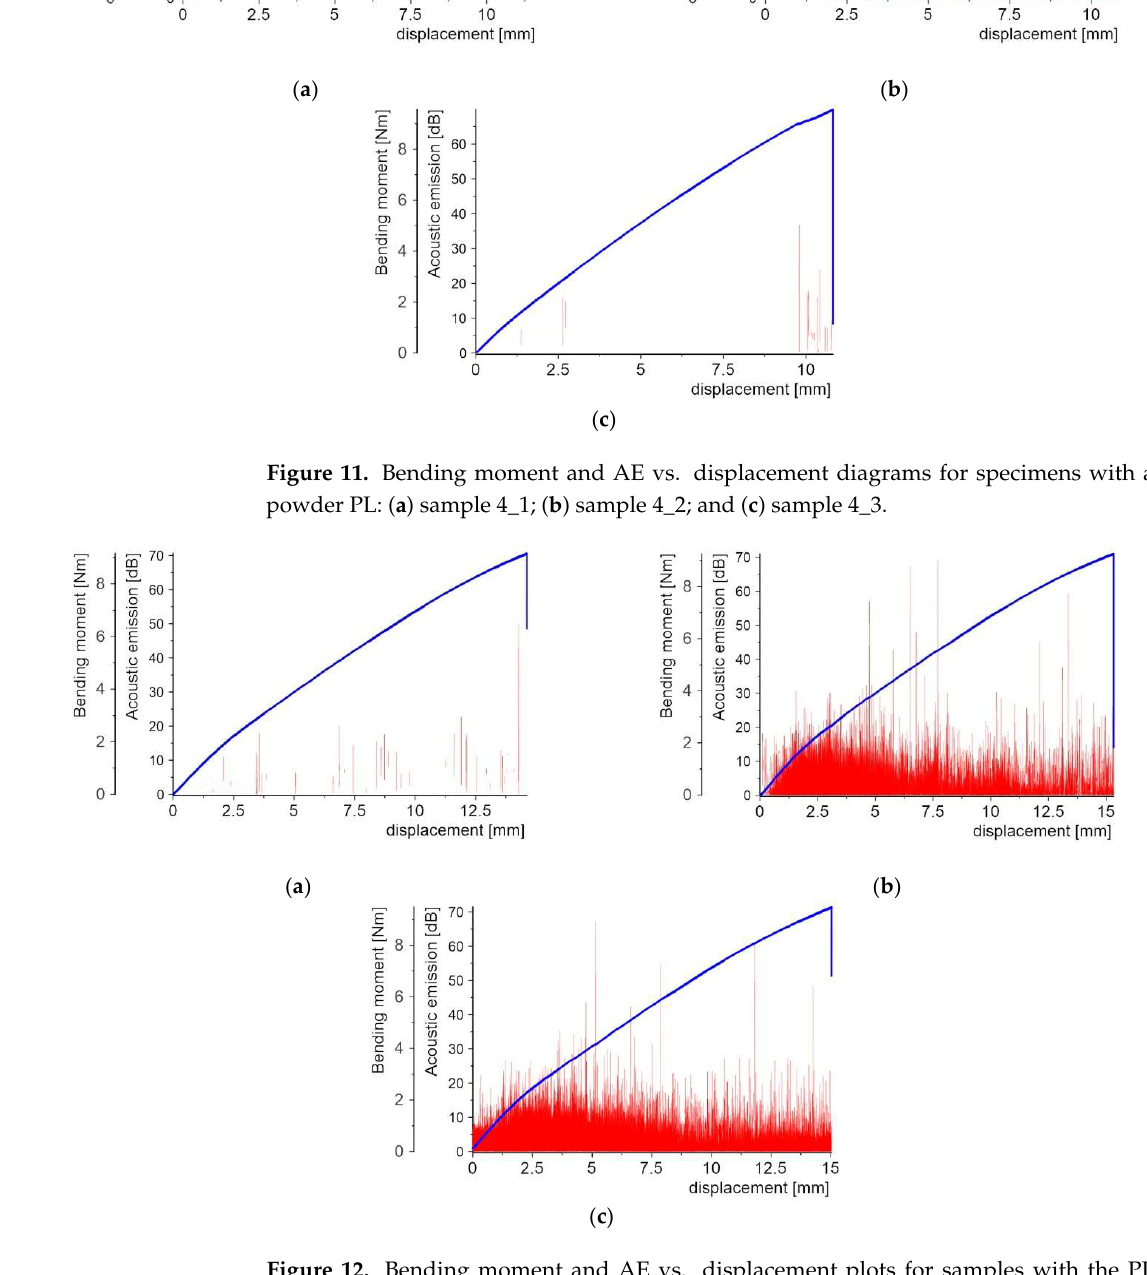
Figure 12. There were no local decreases in bending moment found. The first AE signals initiated Figure 12. Bending moment and AE vs. displacement plots for samples with the PL made of for the bending moment were equal to about 4.6 Nm, which corresponds to a displacement of 5 mm crystalline silica powder: ( a ) sample 5_1; ( b ) sample 5_2; and ( c ) sample and values at the level of 50–60 dB. The bending moment-displacement diagram becomes continu- ously nonlinear up to the final failure. ( a ) 5_1, ( b ) 5_2, ( c ) 5_3.